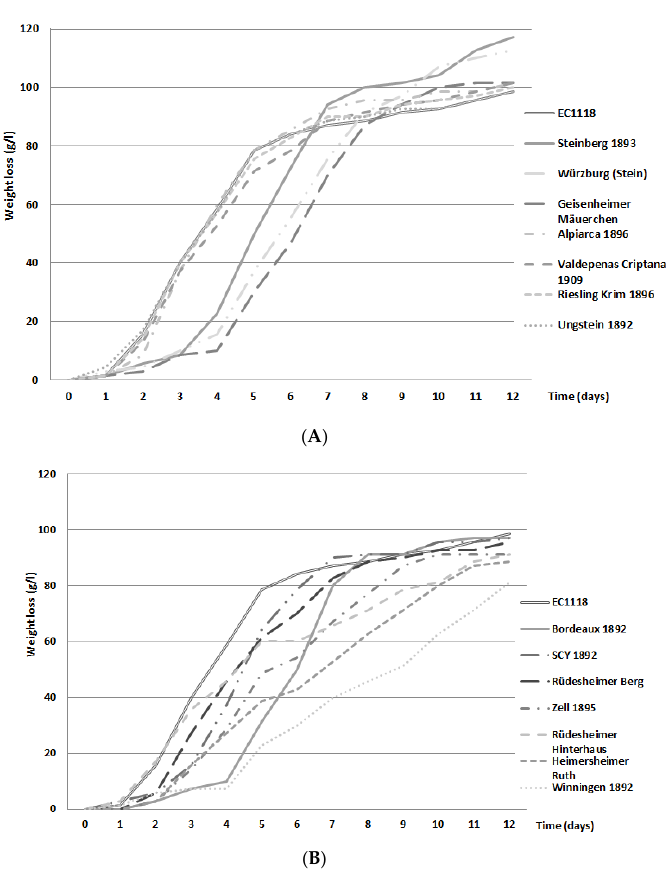
Figure 2. Fermentation curves based on CO 2 release/weight loss of Saccharomyces cultures derived from isolates of the old collection. Release of CO 2 was measured daily. ( A ) Strains are shown that released more CO 2 than the EC1118 control wine yeast strain. ( B ) Strains are shown that released less CO 2 than the EC1118 control wine yeast